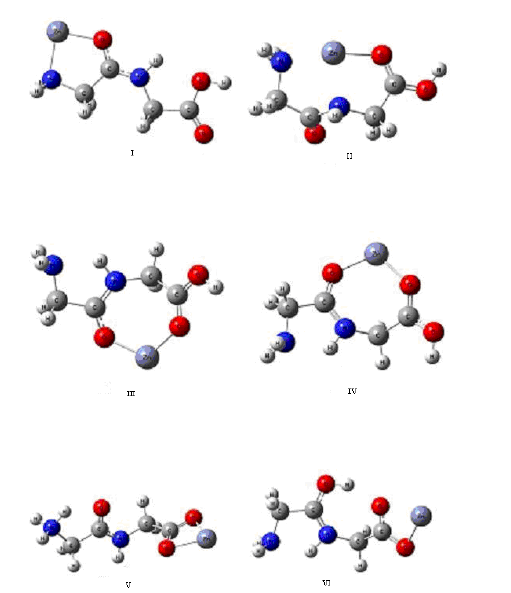
Figure 1. Optimized structures of glycylglycine –Zn 2+